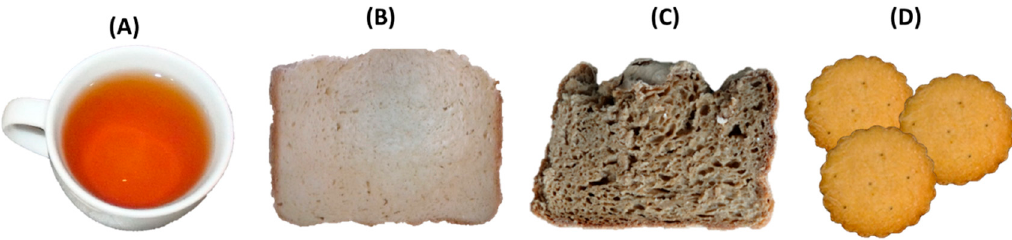
Figure 5. ( A ) Novel beverages from Arabica and Robusta CSE. ( B ) Wheat bread slice. ( C ) Gluten-free bread with CSE. ( D ) Biscuits with CSE. Novel foods were developed by the Food Bioscience Research Group at the Instituto de Investigación en Ciencias de la Alimentación (CIAL, UAM-CSIC), Madrid, Spain.